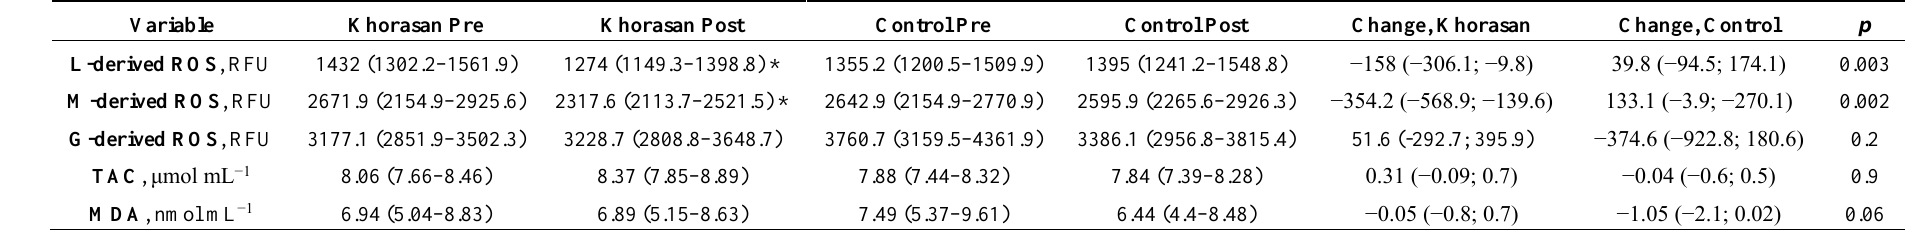
Table 3. Modifications in oxidative stress—related parameters a